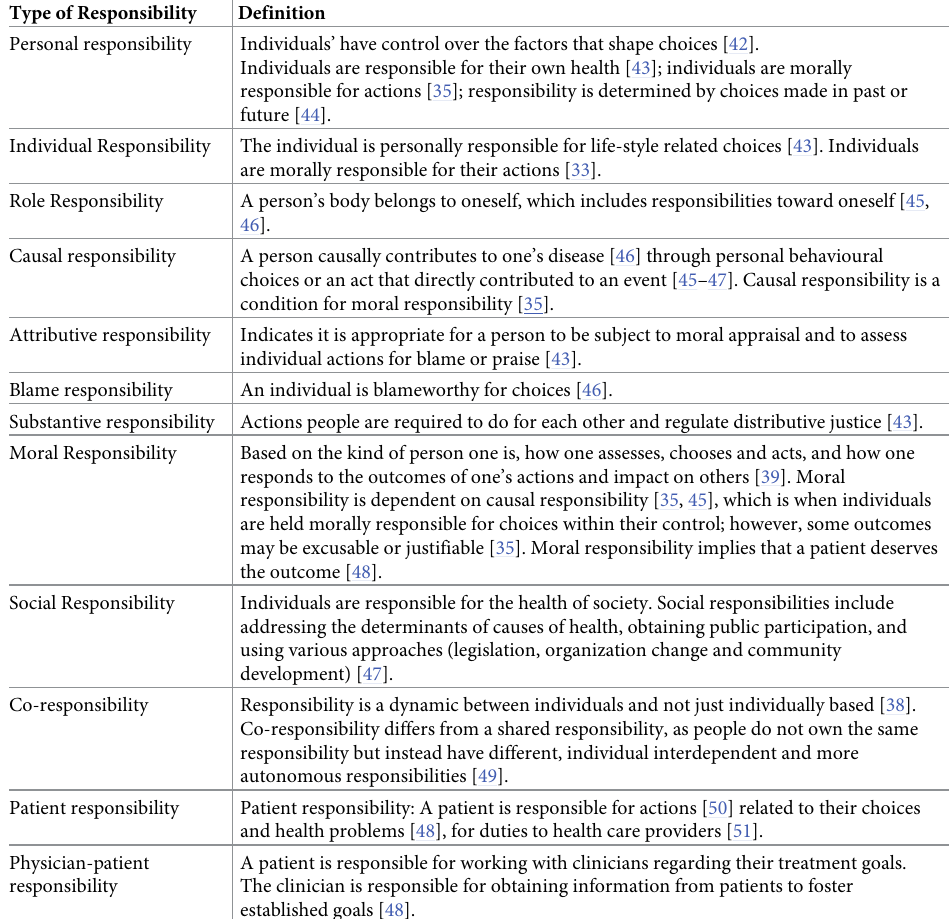
Table 2. Definitions of